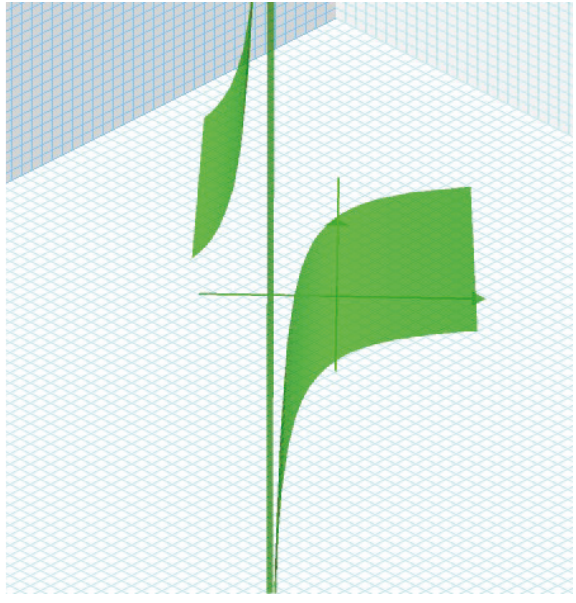
Figure 8: Geometrical representation of approximate solution of (76).